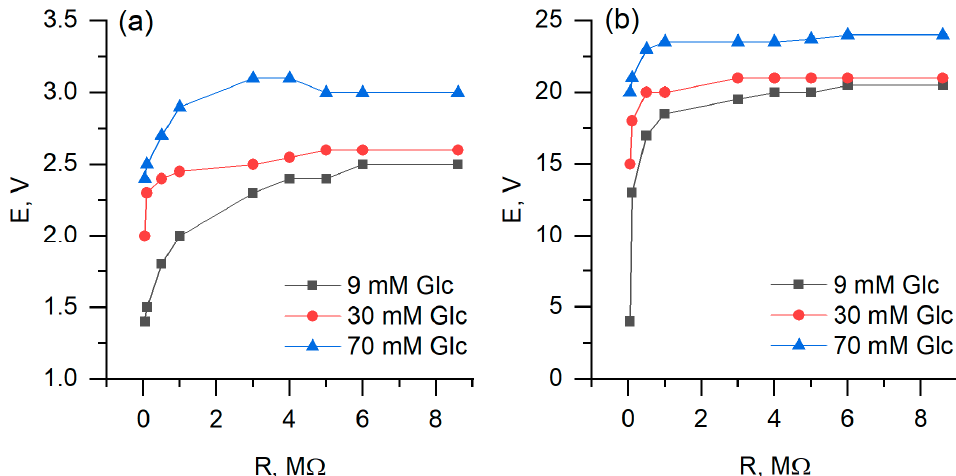
Figure 11. Generated potential dependence on applied load, using ( a ) PQ- and ( b ) PQ/MW-CNT- modified graphite electrode as an anode.